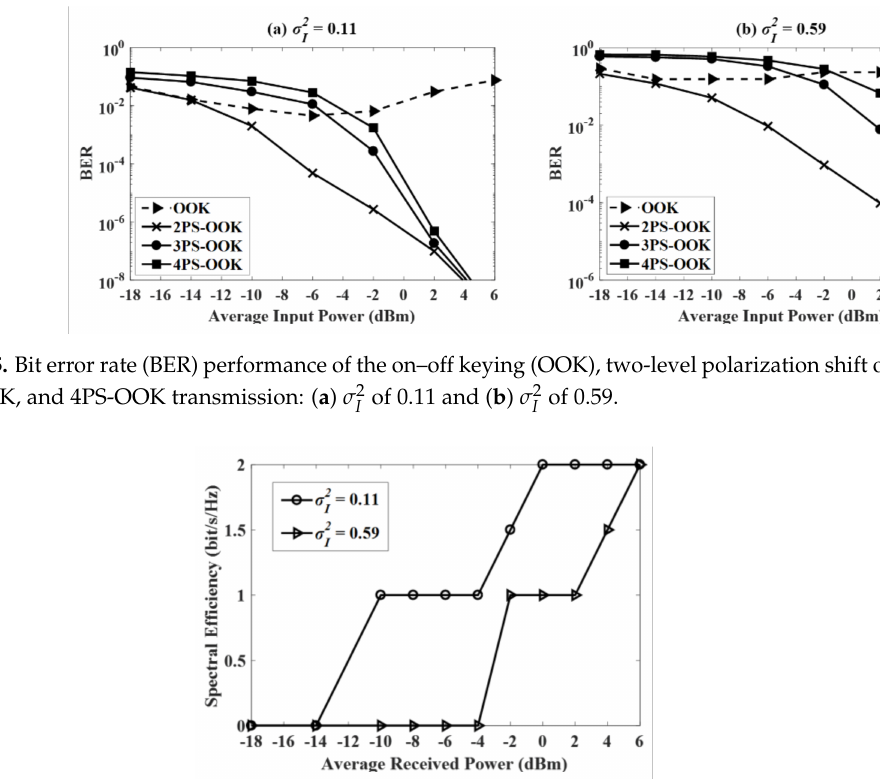
Figure 6. Spectral efficiencies (SEs) of the proposed technique at a BER of 1 × 10 − 3